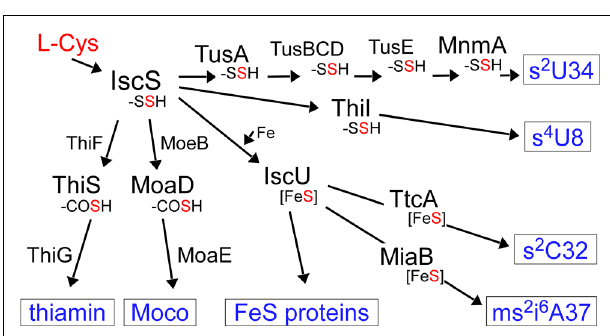
FIGURE 2 | Sulfur flow in the biosynthesis of various sulfur-containing molecules in E. coli . The sulfur atom in cysteine is first activated by IscS as a persulfide.The persulfide sulfur on IscS is delivered to acceptor proteins in each pathway. -SSH: persulfide, -COSH: thiocarboxylate, Fe–S: iron–sulfur cluster, Moco: molybdenum cofactor.